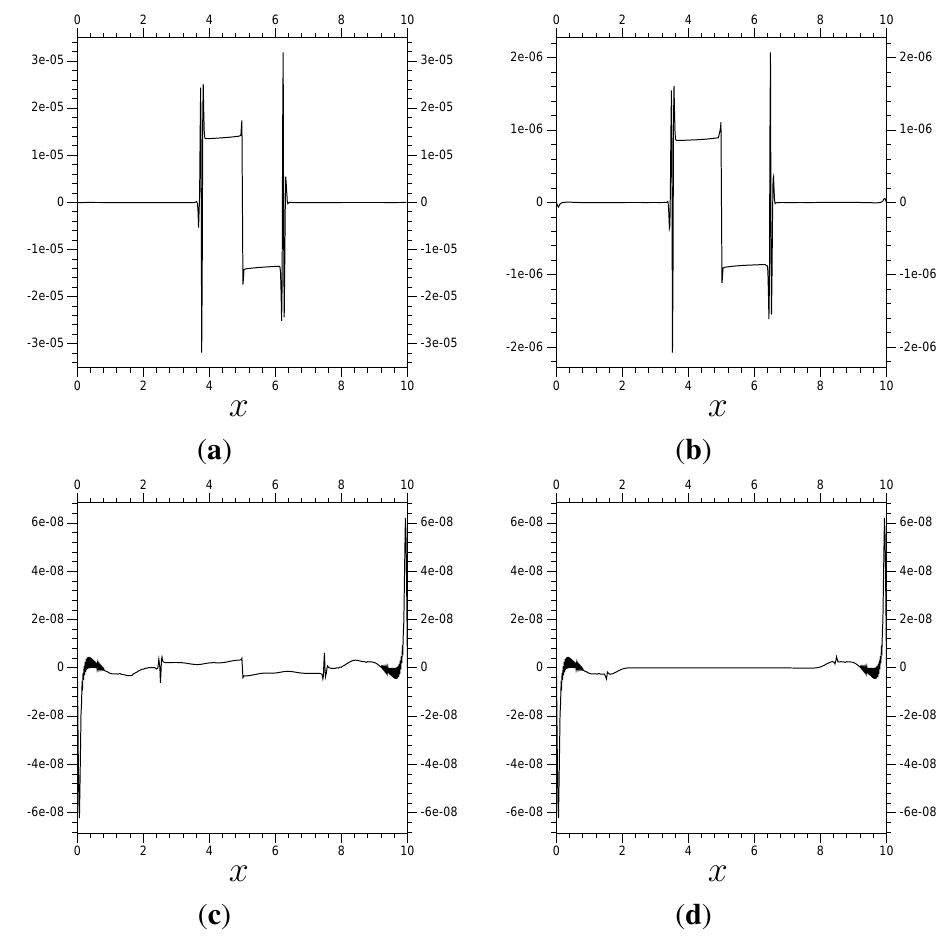
Figure 8. Error from results using V − between the multi-scale results and the V − multi-scale results differ in their Λ sub-domains. All use 4 “extra” terms per boundary of Λ . ( a ) Λ = (3 . 75 , 6 . 25) ; ( b ) Λ = (3 . 50 , 6 . 50) ; ( c ) Λ = (2 . 50 , 7 . 50) ; ( d ) Λ = (1 . 50 , 8 . 50)